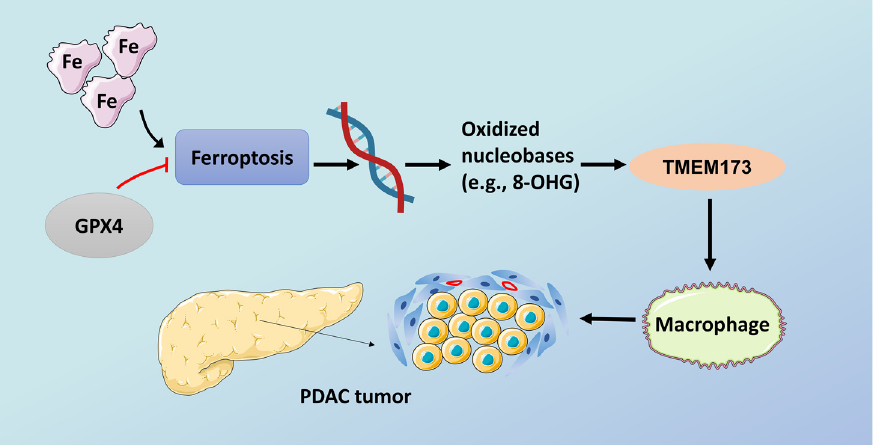
Figure 2. Ferroptosis promotes tumorigenesis in pancreatic cancer. GPX4, glutathione peroxidase 4; TMEM173, transmembrane protein 173. Schematic depicting the role of high-iron diets or GPX4 depletion in Kras-driven PDAC. The induction of ferroptosis by either high-iron diets or GPX4 depletion promotes oxidized nucleobase (e.g., 8-OHG) release and thus activates the TMEM173-dependent DNA sensor pathway, which finally results in macrophage infiltration and activation during Kras-driven PDAC. Consequently, macrophage depletion or pharmacological and genetic inhibition of the 8-OHG–TMEM173 pathway suppresses ferroptosis-mediated pancreatic tumorigenesis. The red line means the overexpression of GPX4 can inhibit the progression of ferroptosis.